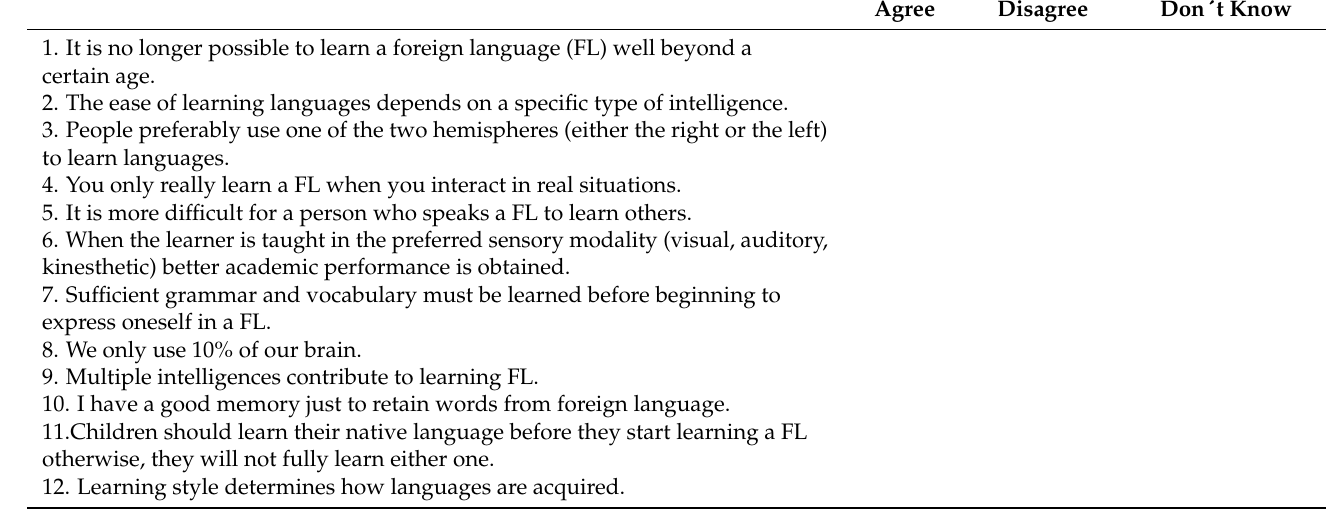
Table A1. Questionnaire items and acceptance degree.